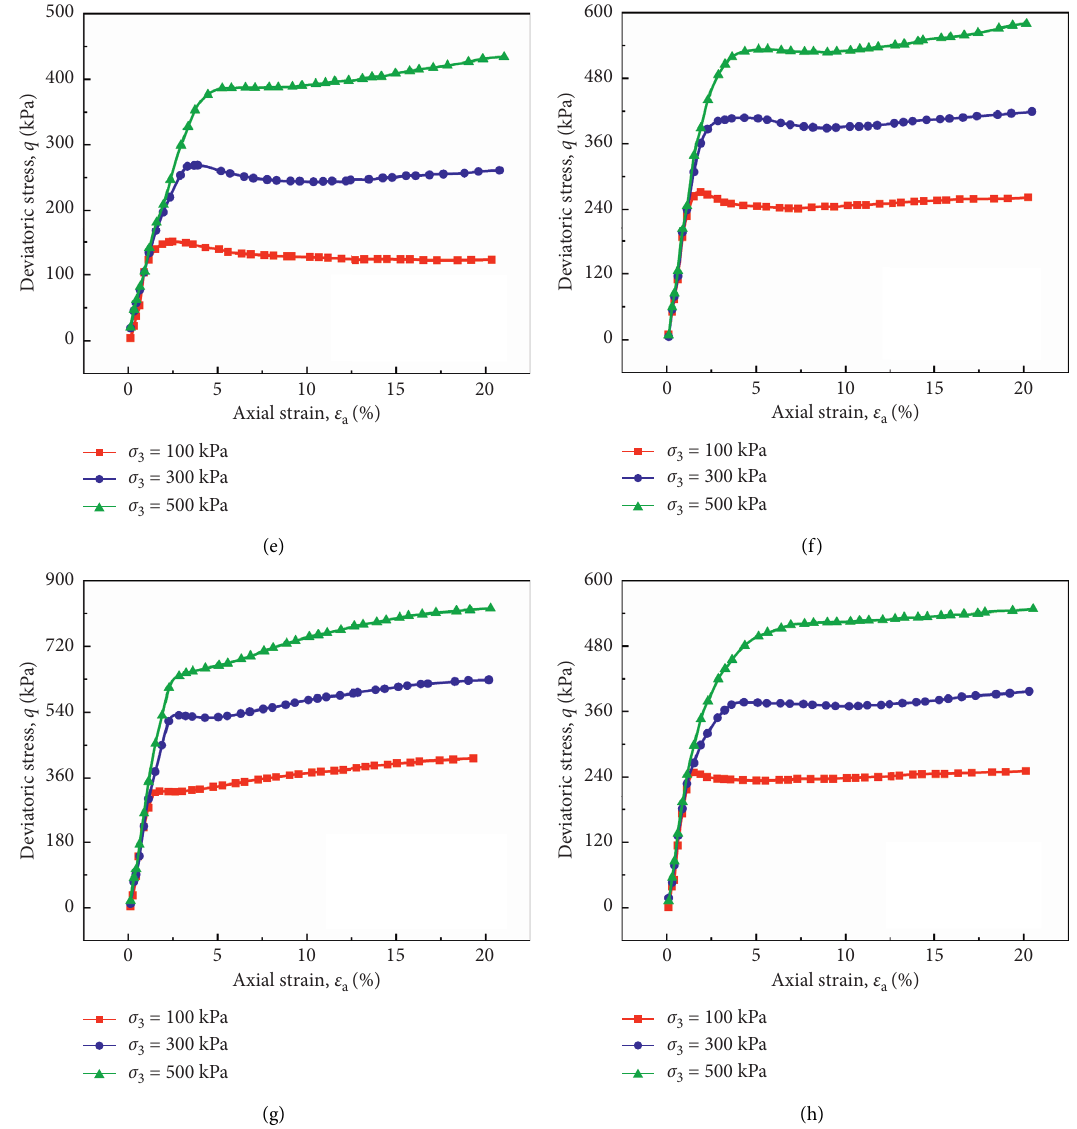
Figure 4: Stress-strain curves of laterite and GN-laterite, (a) ρ M � 0%, (d) ρ d � 1.40 g/cm 3 , M � 0.5%, (e) ρ d � 1.30 g/cm 3 , M � 1.0%, (f) ρ d � 1.40g/cm 3 , M � 1.0%, (g) ρ d � 1.50g/cm 3 , M � 1.0%, and (h) ρ d � 1.40 g/cm 3 , M �